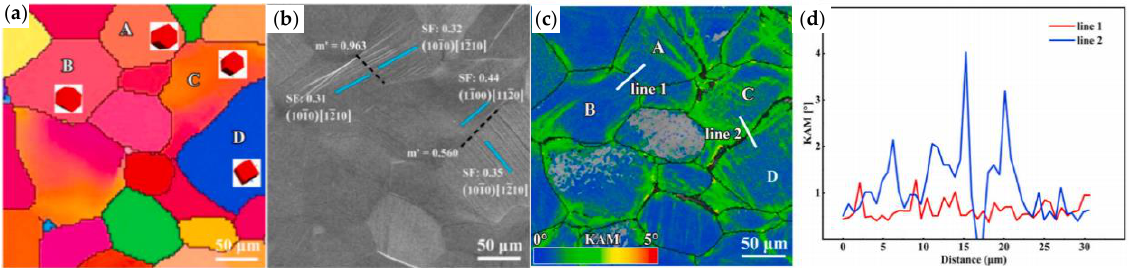
Figure 5. Slip transfer and blocking in Ti-6Al alloy: ( a ) IPF map; ( b ) SEM map; ( c ) KAM map; ( d ) linear distributions of KAM values perpendicular to grain boundaries A/B and C/D [47].